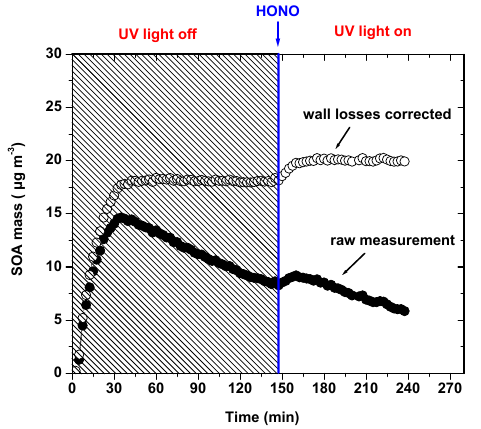
Figure 5. The measured aerosol mass concentration in the chamber as a function of time and the wall-loss-corrected SOA mass concen- tration (for w = 1) (Experiment 31). The shaded part indicates the period when the UV light was off, and the other section represents the period when the UV light was on. Also shown is the time when HONO was injected into the chamber.